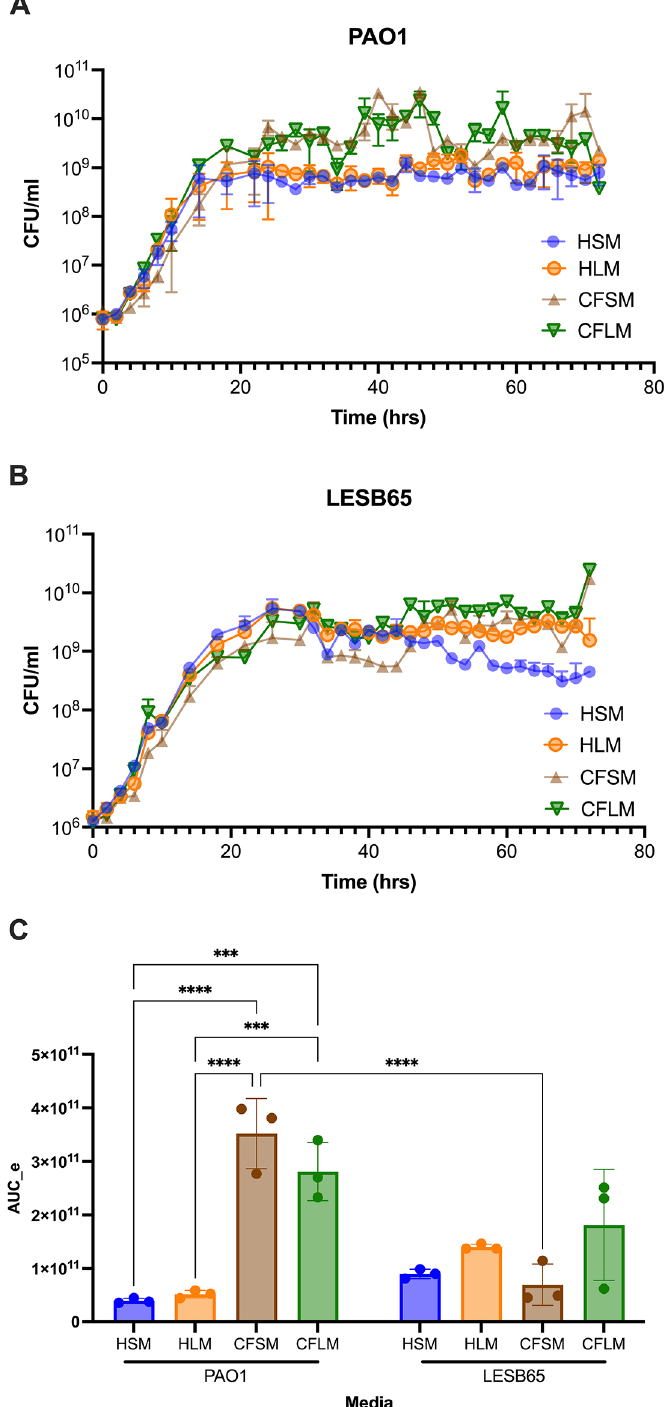
Figure 1. Continuous growth of PAO1 and LESB65 in respiratory media for 72 hrs. Media were generated using M9 supplemented with the chosen concentrations of all the chemicals shown in tables within media preparation protocol section. These concentrations differed between sinuses and lung and between health and CF, generating four different media: Healthy sinus media (HSM), CF sinus media (CFSM), healthy lung media (HLM) and CF lung media(CFLM).CFUcountsaremadebytakingasamplefrombacterialculturegrownineachdevelopedmedia,every 2 hours, for 72 hours. Data shows mean of 3biological replicates per time point, error bars show standard deviation. A: PAO1, B: LESB65, C: Area under the exponential curve values for PAO1 and LESB65 grown in the four media. Statistical analysis was with two-way ANOVA with Sidak ’ s multiple comparison test. Only within-strain and within- media pairwise comparisons are shown. ***p < 0.001, ****p <